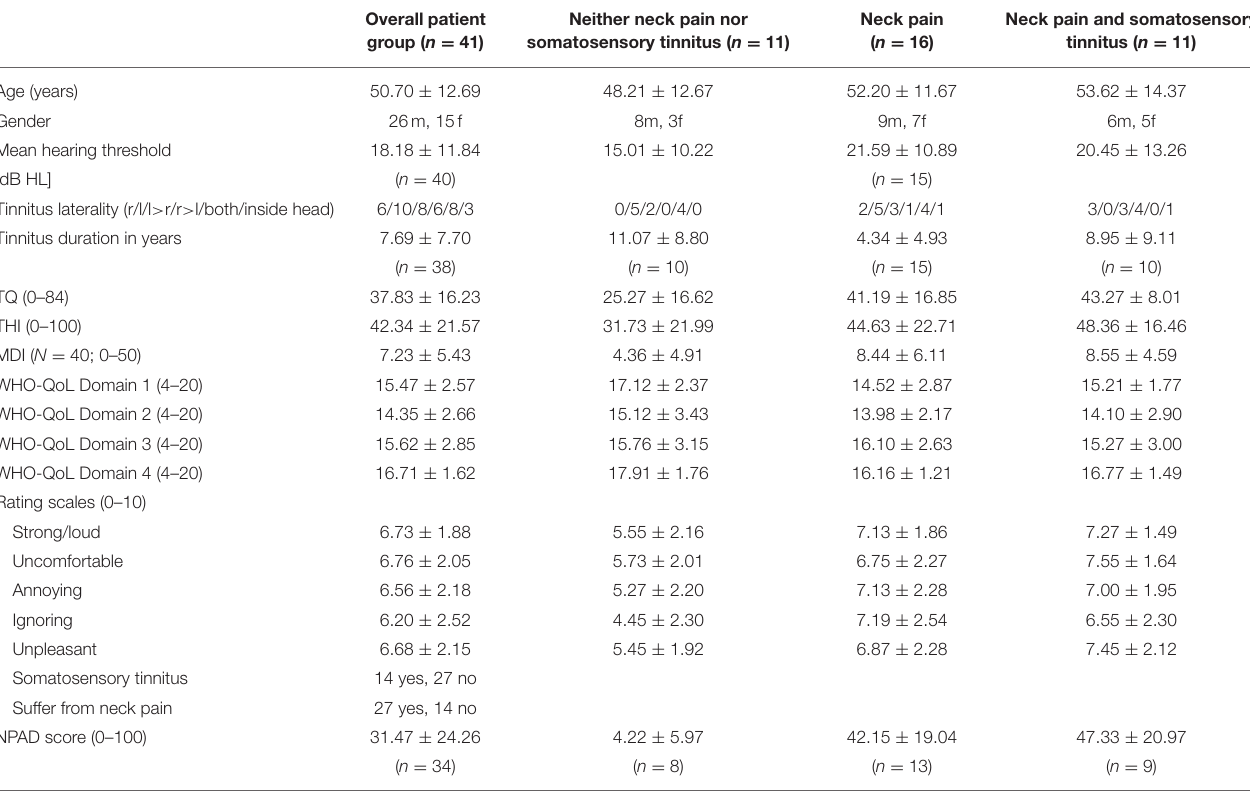
TABLE 1 | Demographical data and clinical characteristics at baseline (M ± SD) for the overall patient group and for the three exploratory subgroups. Overall patient group ( n = 41)